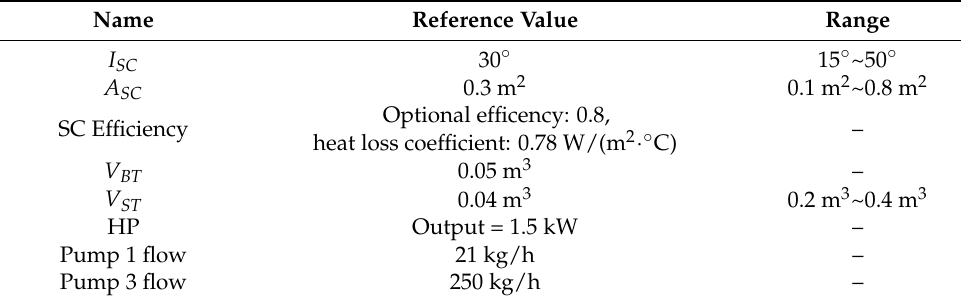
Figure 1. Schematic diagram of SCAHP. Table 1. Characteristics of the